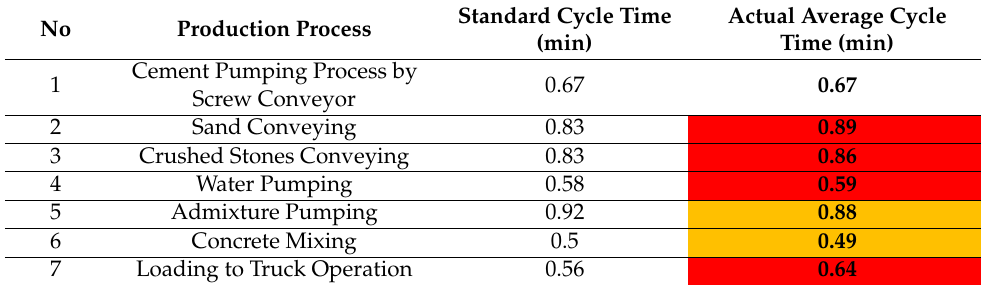
Inefficiency of operation/potential future machine breakdowns. calibration/potential future machine